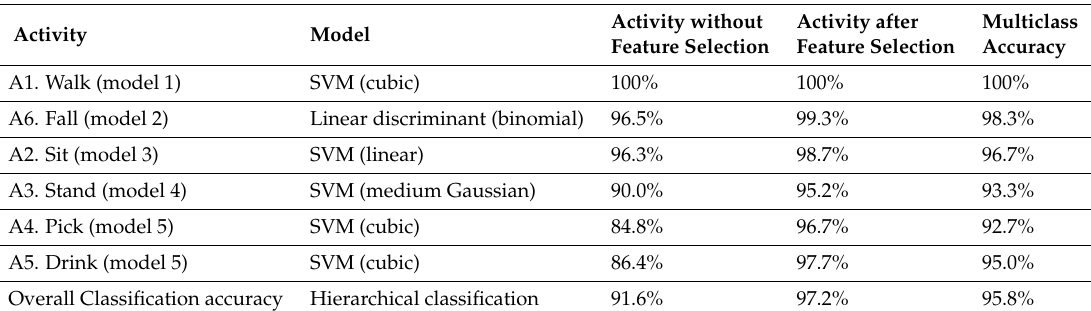
Figure 16. Hierarchical classification structure. Table 6. Classification results from one-versus-all models with and without feature selection vs multiclass accuracy.